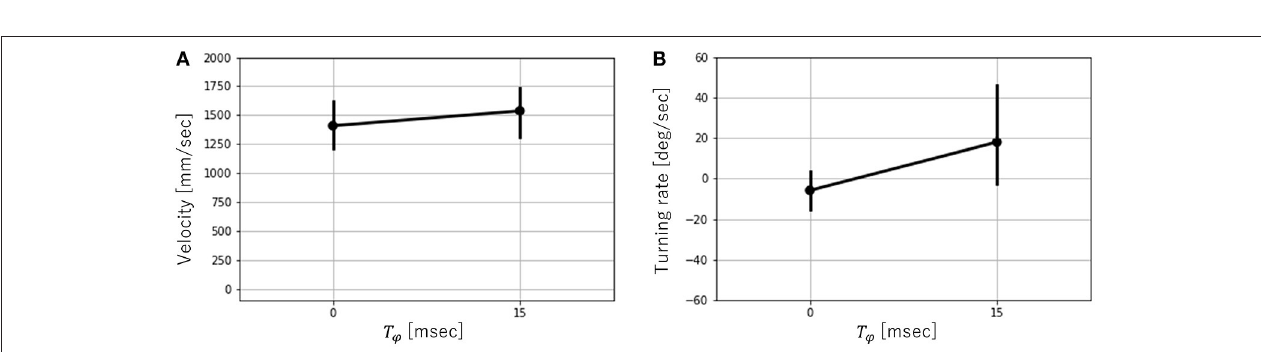
FIGURE 9 | (A) Velocity vs. T φ and (B) Turning rate vs. T φ with T = 300. Error bars show one standard deviation.